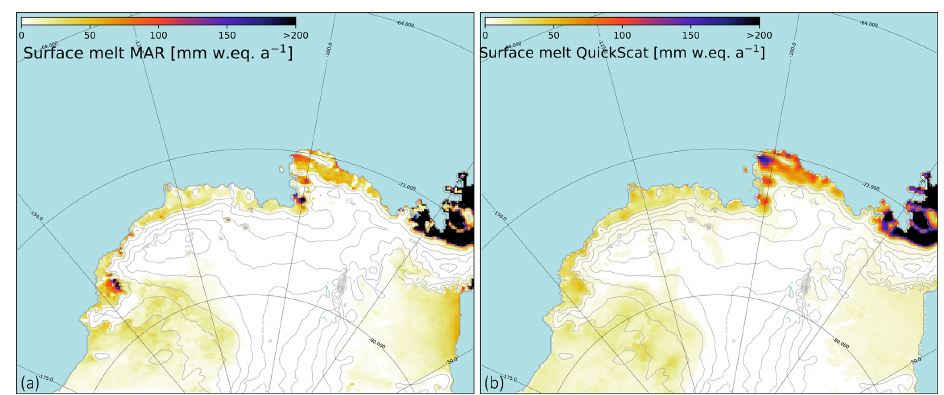
Figure 5. Annual surface melt rate (a) simulated by MAR over 1999–2009 and (b) derived from QuickSCAT satellite data over the same period (Trusel et al., 2013) and interpolated over the MAR grid.